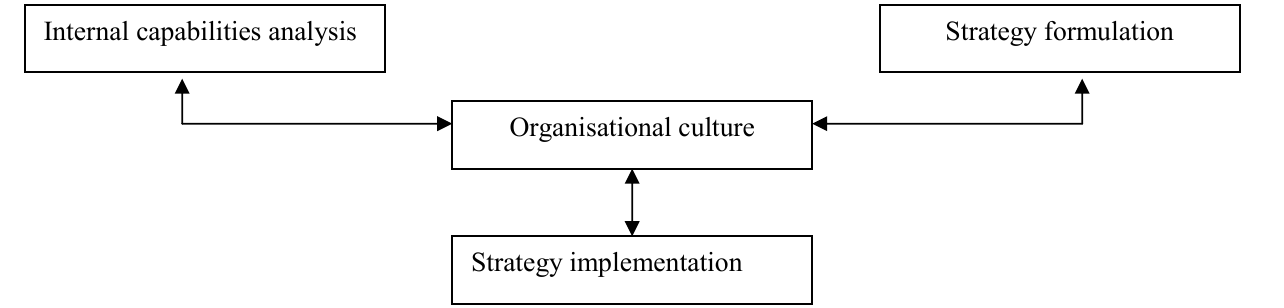
Figure 2: The central role of organisational culture in strategic